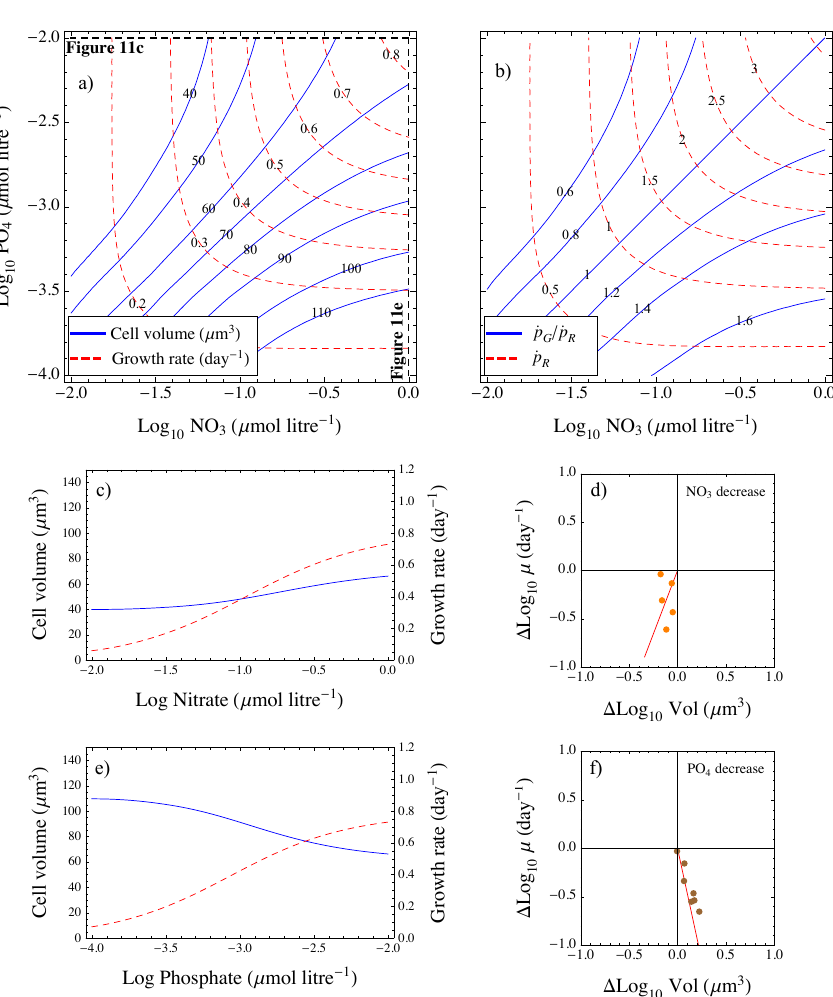
Figure 11. Effect of changing nitrate and phosphate concentrations on modelled cell volume and growth rate ( a , c , d , e and f ) and on the maturation flux P R and the ratio of the growth to maturation fluxes P G /P R (b) . Notes: the data points in (d) and (f) correspond to the shifts in cell size and growth rate observed in laboratory cultures with E. huxleyi subject to a decrease in nitrate (d) and phosphate (f) concentrations.